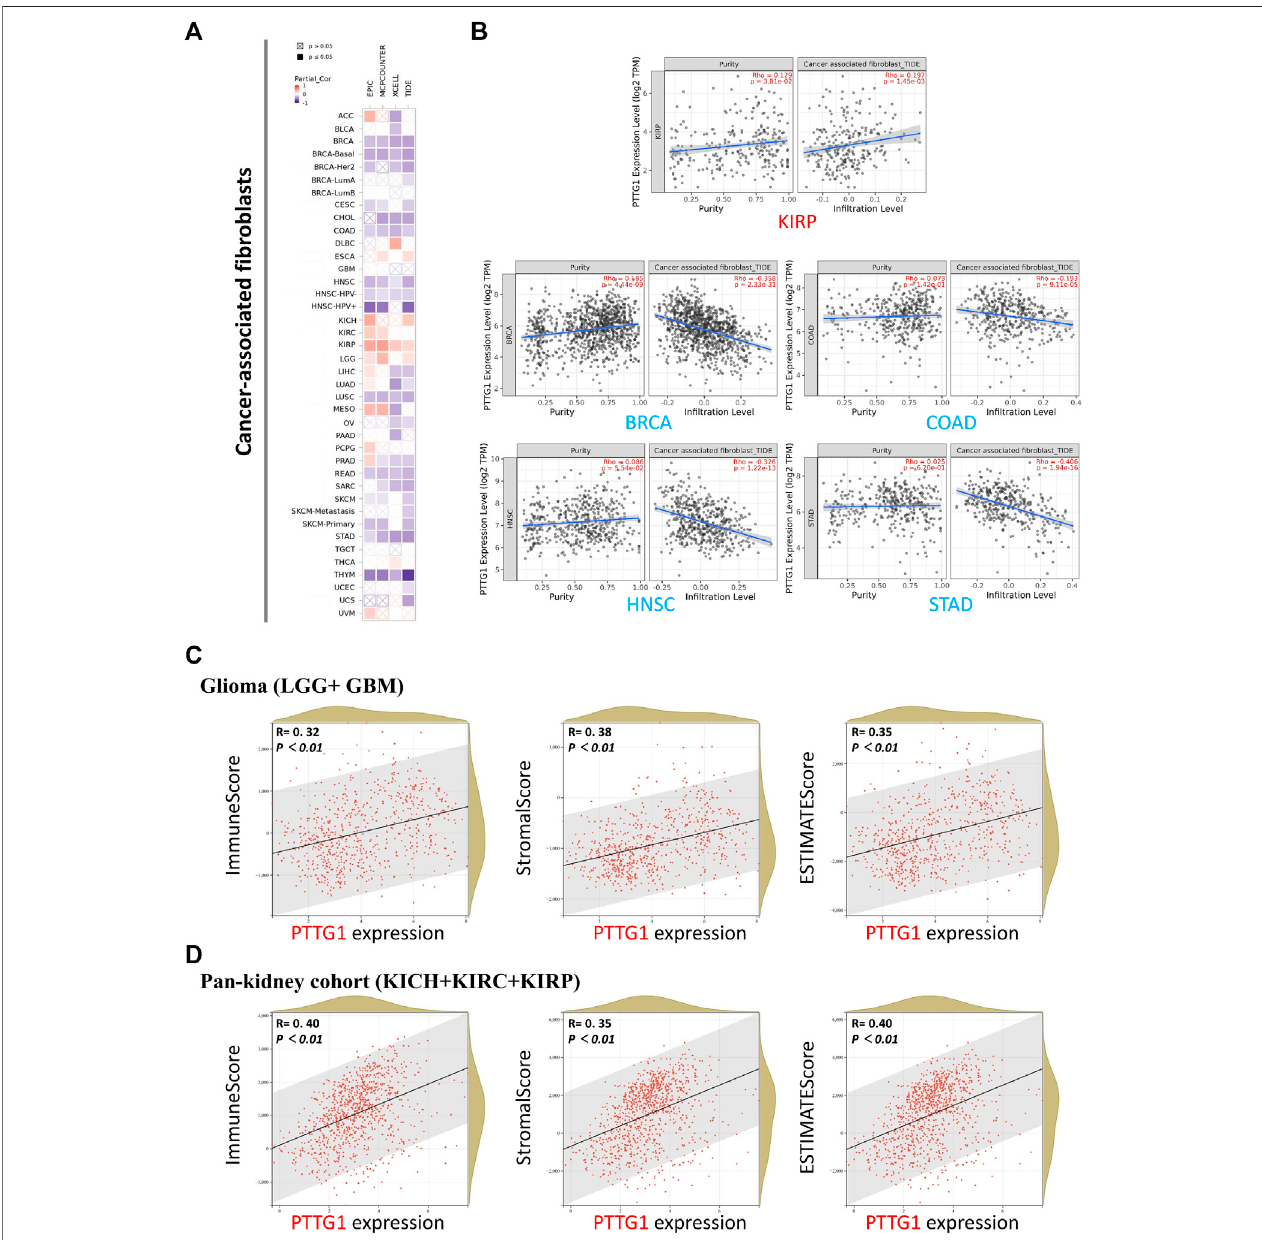
FIGURE 7 | Cancer-associated fi broblasts analysis and immune check point of PTTG1. (A) Association between PTTG1 expression and immune in fi ltration of cancer-associated fi broblasts in different tumors. (B) The scatter plots of cancer-associated fi broblasts immune in fi ltration in different tumors generated based on a certain algorithm. The analysis of correlation between PTTG1 expression and ImmuneScore, StromalScore and ESTIMATEScore was conducted. Two kinds of typical tumors (C) glioma (LGG + GBM) (D) Pan-kidney cohort (KICH + KIRC + KIRP) were displayed.